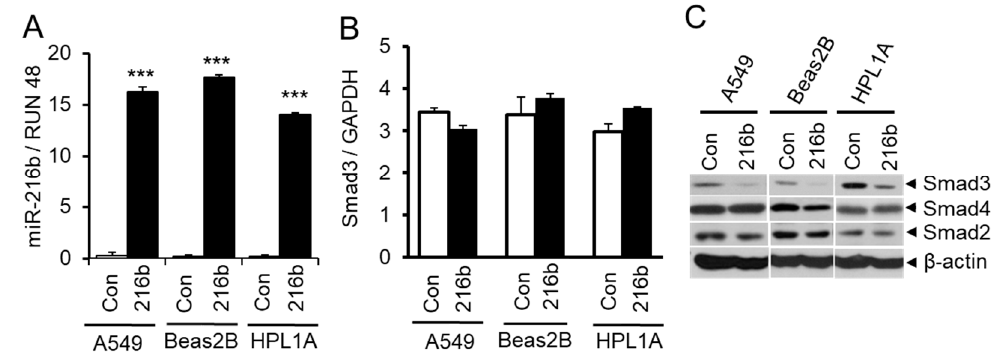
Figure 3. Downregulation of Smad3 by miR-216b in lung epithelial cells. ( A ) Immortalized normal human lung epithelial cell lines HPL1A and Beas2B and human lung adenocarcinoma cell line A549 were transfected with miR-216b mimic or control mimic. Forty-eight hours after transfection, RNA was purified and miR-216b expression was analyzed by qRT-PCR, *** P < 0.001 vs . control (Con) group. ( B ) Total RNA from above cell lines was used for qRT-PCR analyses of Smad3 mRNA expression and normalized by GAPDH. ( C ) HPL1A, Beas2B and A549 cells were transfected with miR-216b mimic or control mimic. Forty-eight hours after transfection, cells were harvested for protein extraction. Smad3, Smad2 and Smad4 protein levels were analyzed by Western blotting with β -actin as loading control.